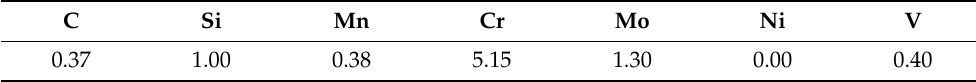
Table 1. Chemical composition of X37CrMoV5-1 steel (% by weight).